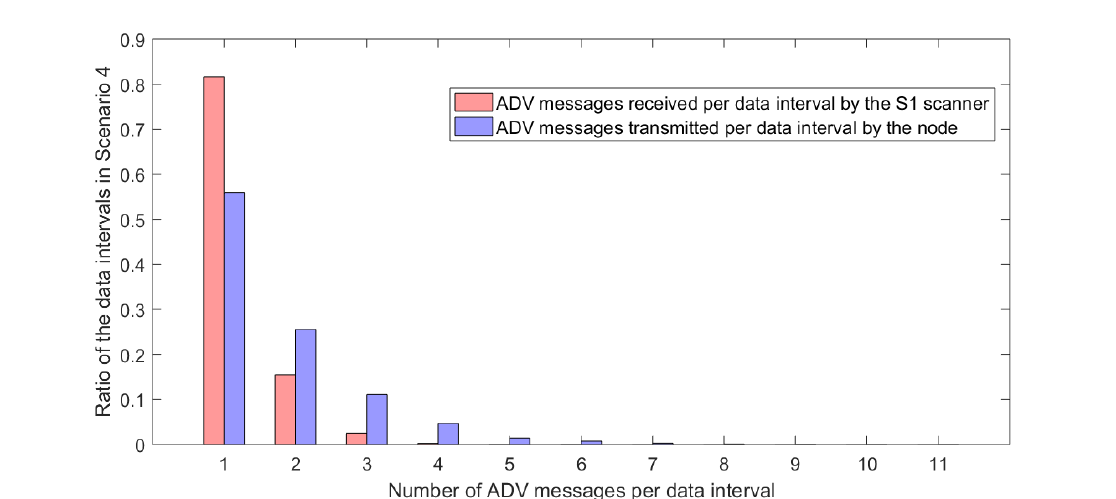
Figure 4. The number of ADV packets transmitted by a single node (blue) and received by the S1 scanner (red) for all data intervals in the experiment scenario